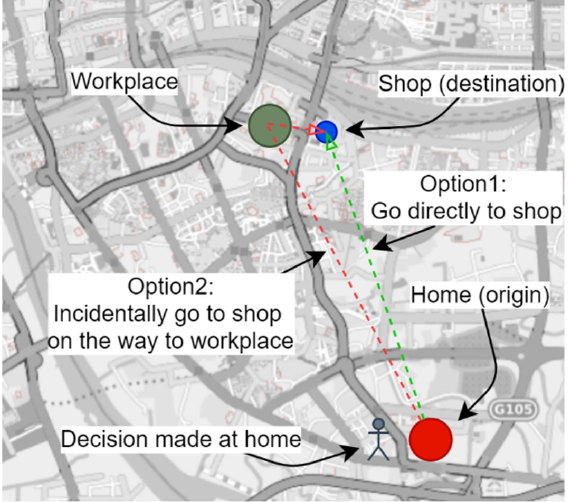
Figure 6. Here, an individual’s active places are his/her home (the red point) and workplace (the green point). The shop (the blue point) is a destination on the to-do list of this individual, near his/her workplace. Because he/she will weigh or balance the cost of making a direct trip to the shop compared to incidentally going to the shop on the way to his/her workplace, the existence of his/her workplace affects his/her travel plans.